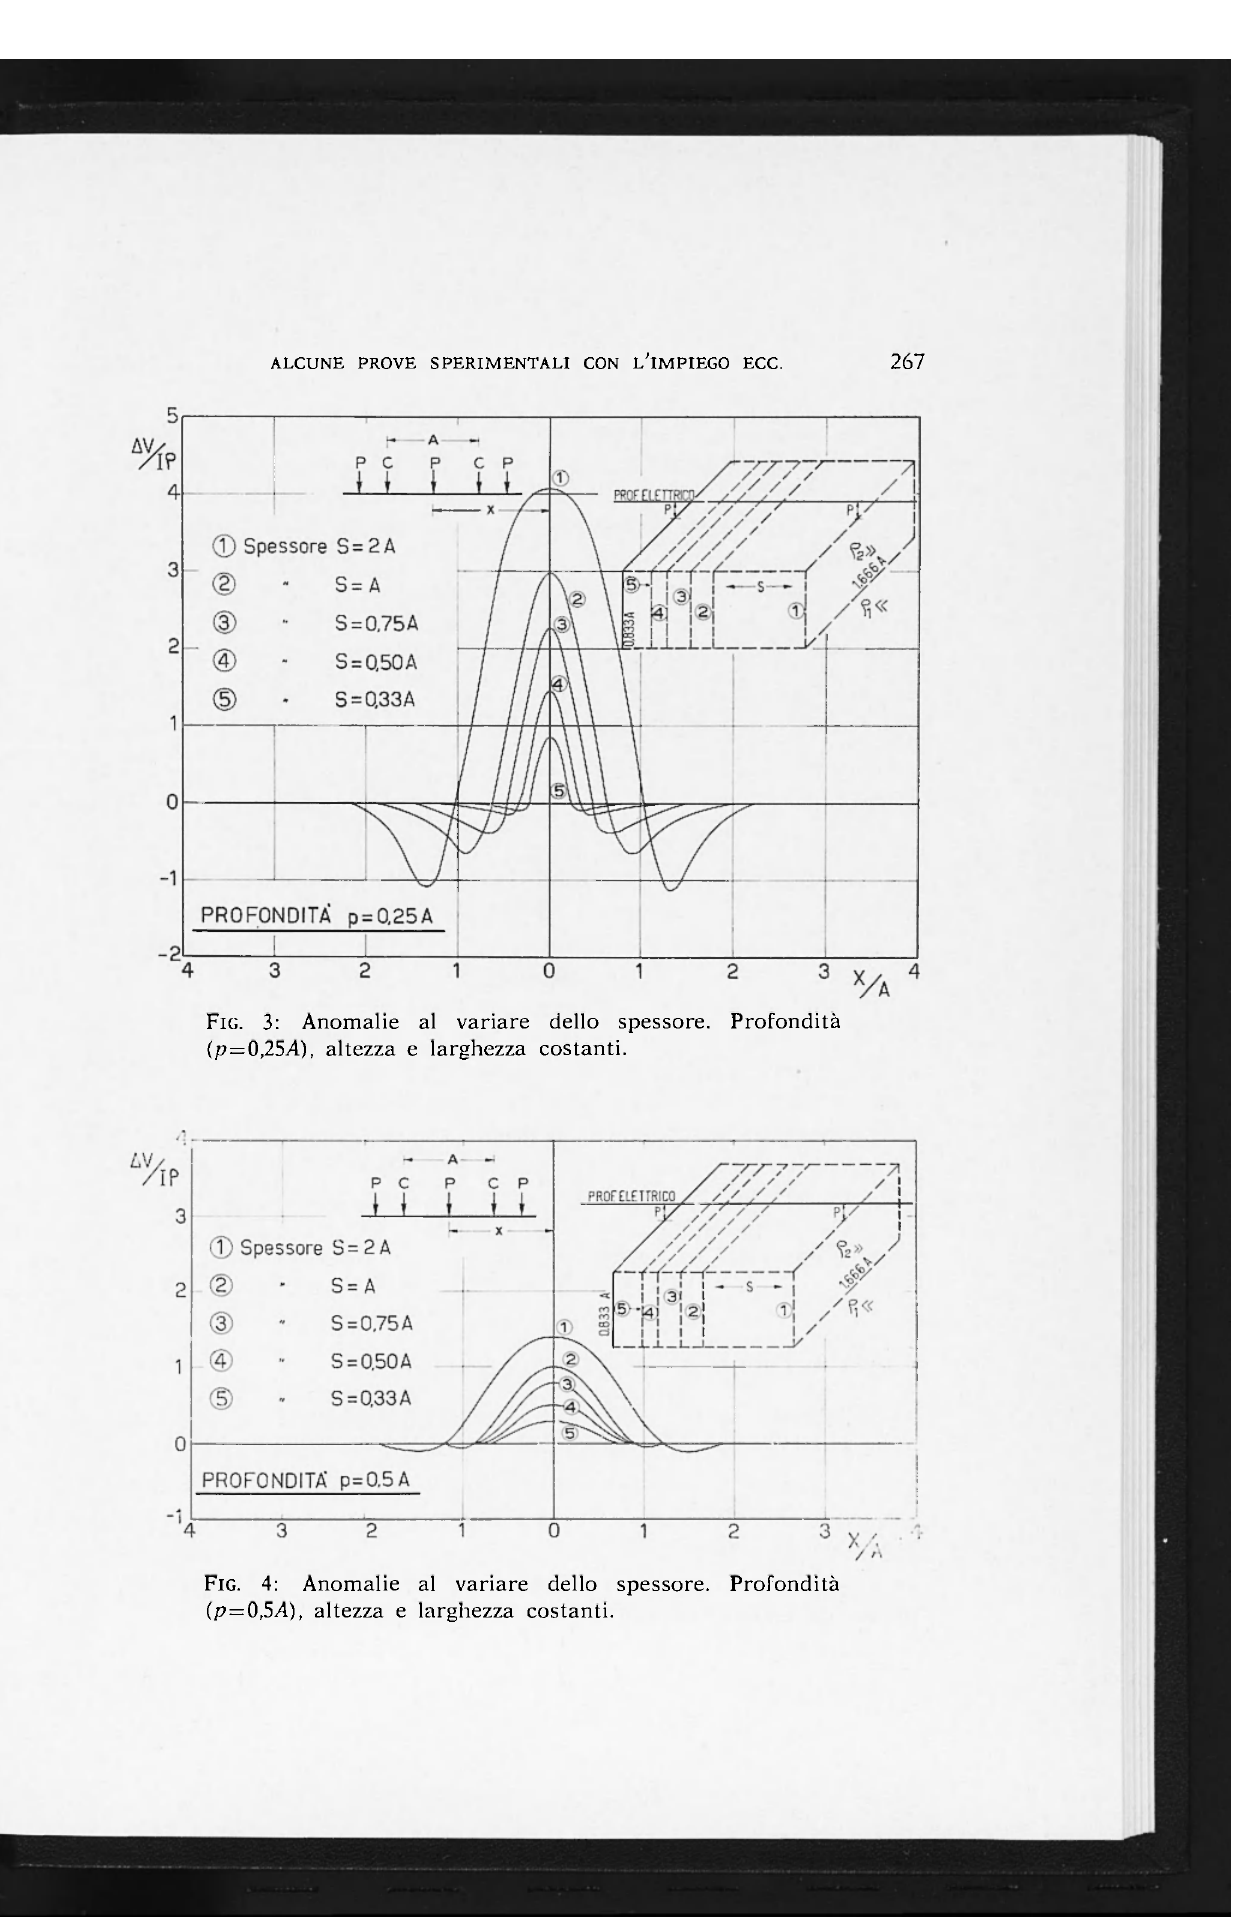
FIG. 3: Anomalie al variare dello spessore. Profondità (p=0,25A), altezza e larghezza costanti.